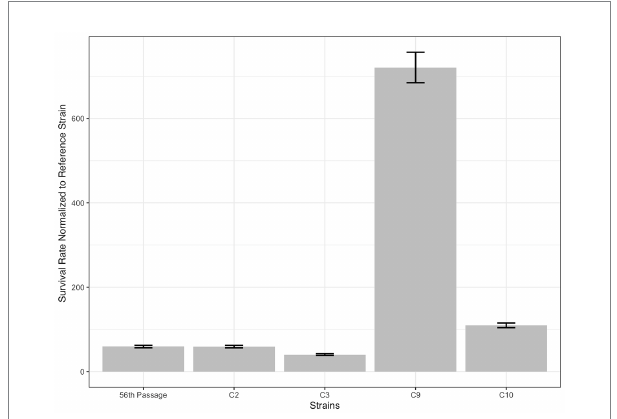
FIGURE 1 2-phenylethanol (2-PE) resistance and cross-resistance test results of the 2-PE-resistant evolved strain C9 and the reference strain (Ref) upon 2-PE (2.5 g/L and 3 g/L), boron (80 mM), cobalt (1 mM and 3 mM), NaCl (0.5 M), and phenylacetate (2 mM)